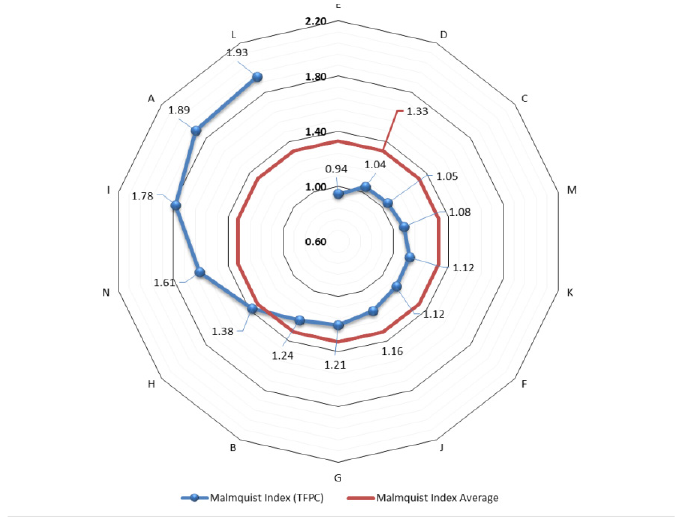
Figure 2: Malmquist Index of Telecommunication Firms in ASEAN-5 Table 4: Malmquist Index Estimation Results on ASEAN-5 Telecommunications Industry